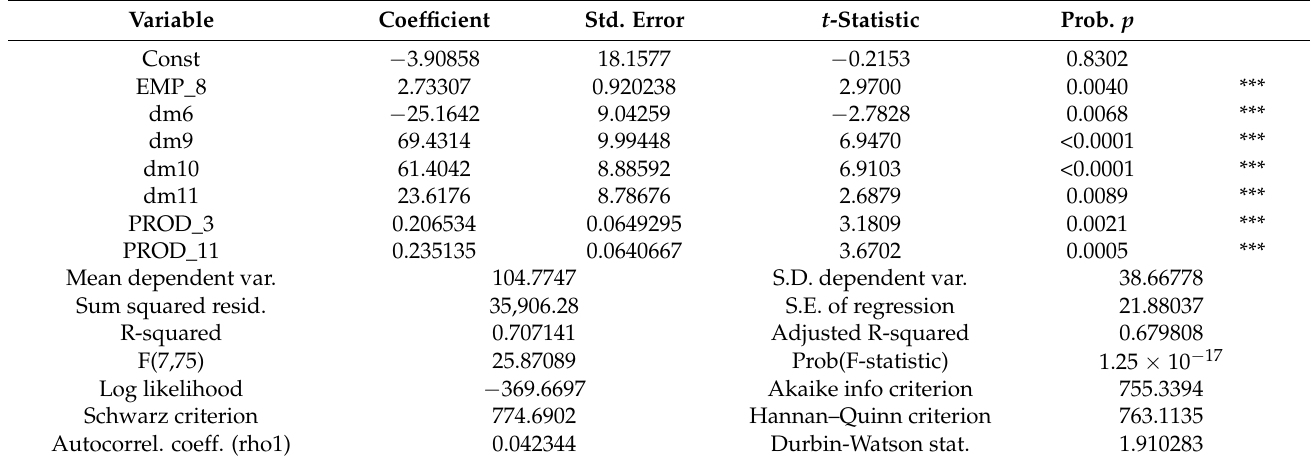
Table 4. Dependent variable: PROD t ; observations used 1997:02–2003:12 (N =